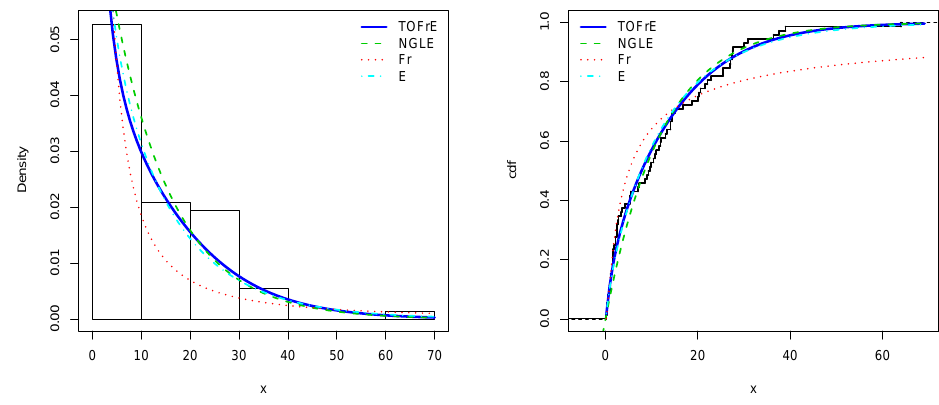
Figure 7. Plots of all the estimated pdfs and cdfs for Data set